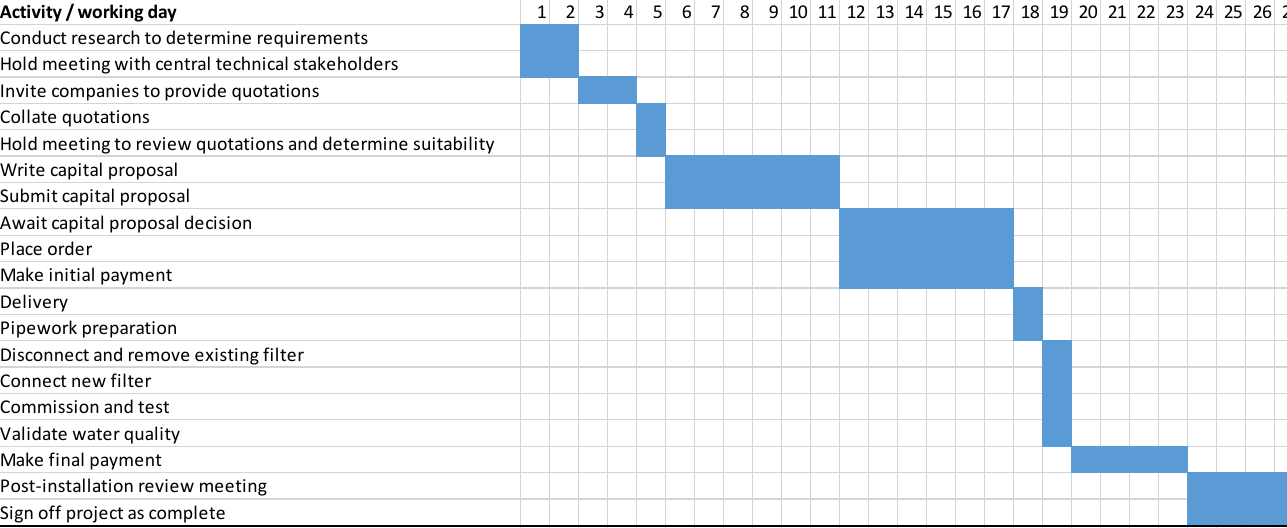
Figure 1. Project Gantt chart.